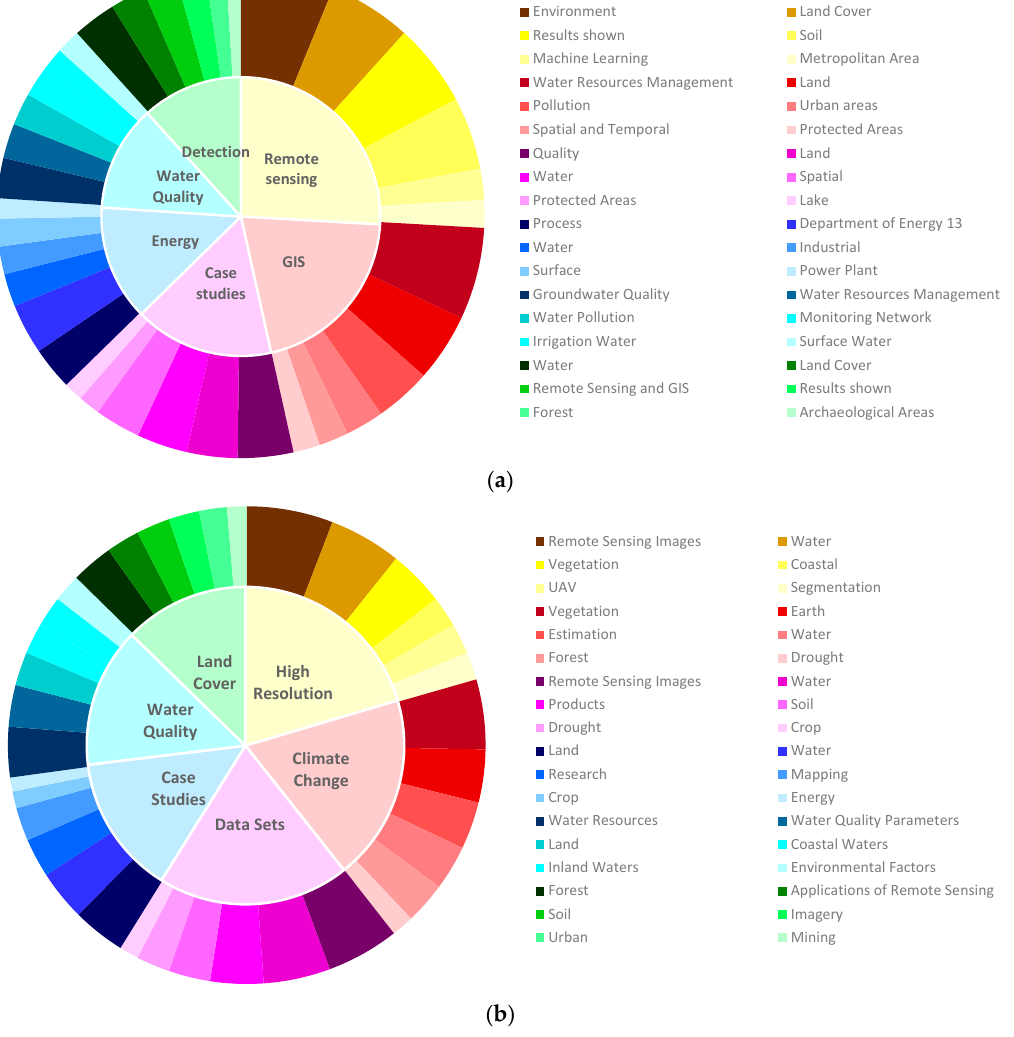
Figure 3. Most repeated topics and subtopics of papers published for ( a ) GIS + environmental monitoring and ( b ) remote sensing + environmental monitoring in the last three years according to [1].